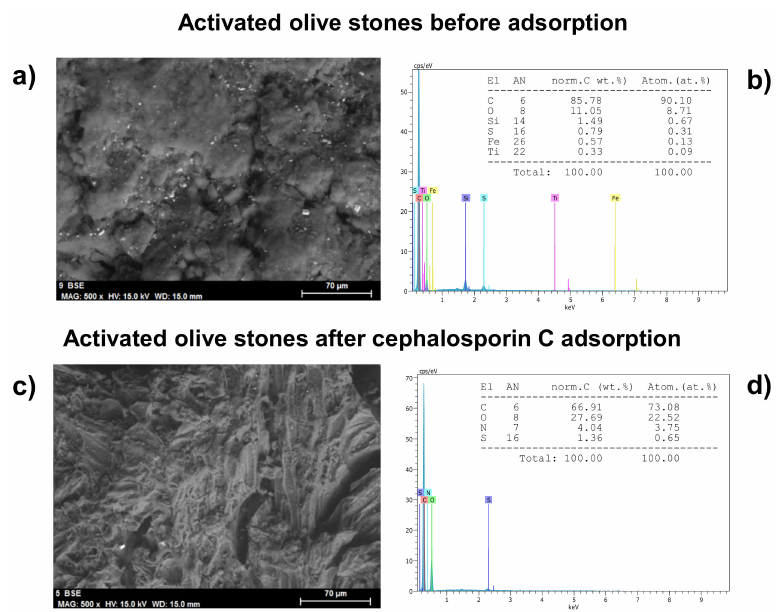
Figure 4. SEM ( a , b ) and EDX ( c , d ) of AOS before and after the adsorption of